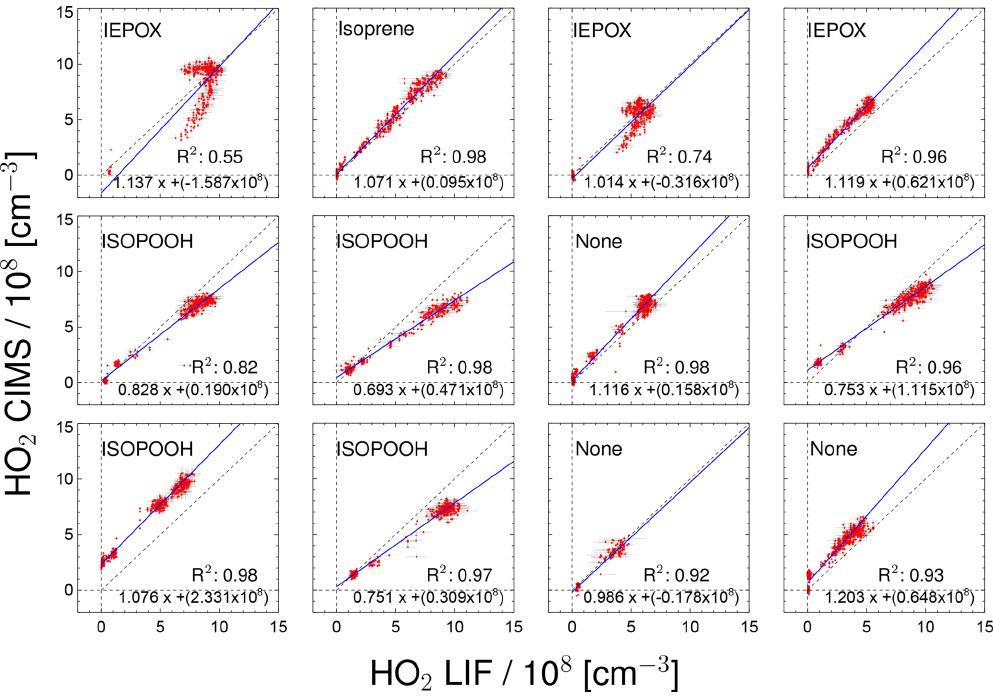
Figure 7. Correlation between HO 2 measurements taken by the CIMS and LIF instruments for individual chamber experiments. Labels in the plots indicate the specific VOC injected into the chamber. For the regression line shown in blue a least-squares fit was performed.